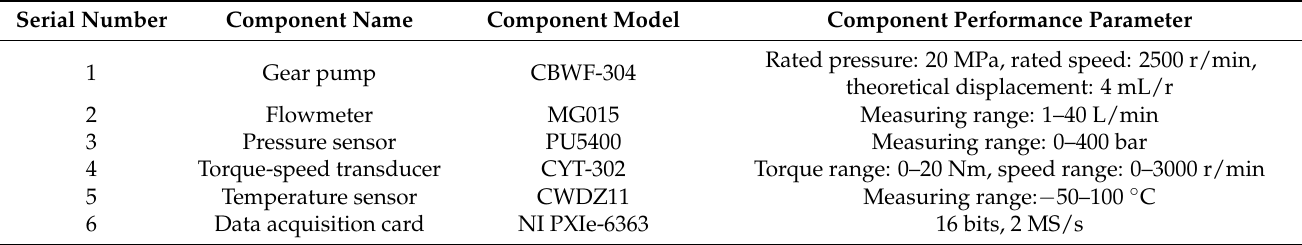
Table 3. Models and performance parameters of main components of test bed.